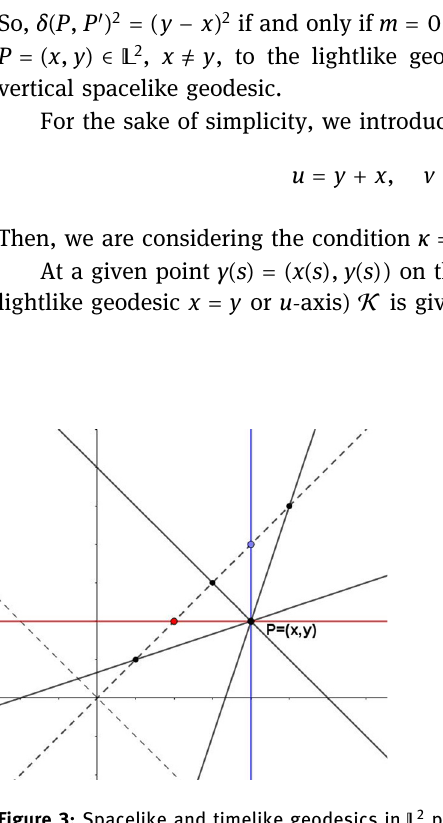
Figure 3: Spacelike and timelike geodesics in (cid:2) 2 passing through P